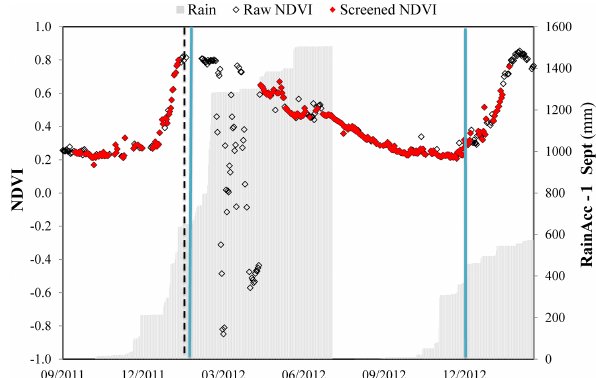
Figure 3. Time series of NDVI values from the unfenced node showing the raw and screened NDVI and the accumulated precipita- tion since 1 September (millimetres) from Townsville Airport BoM weather station. The black dashed vertical line indicates the timing of the controlled burn and the blue lines the start of the wet